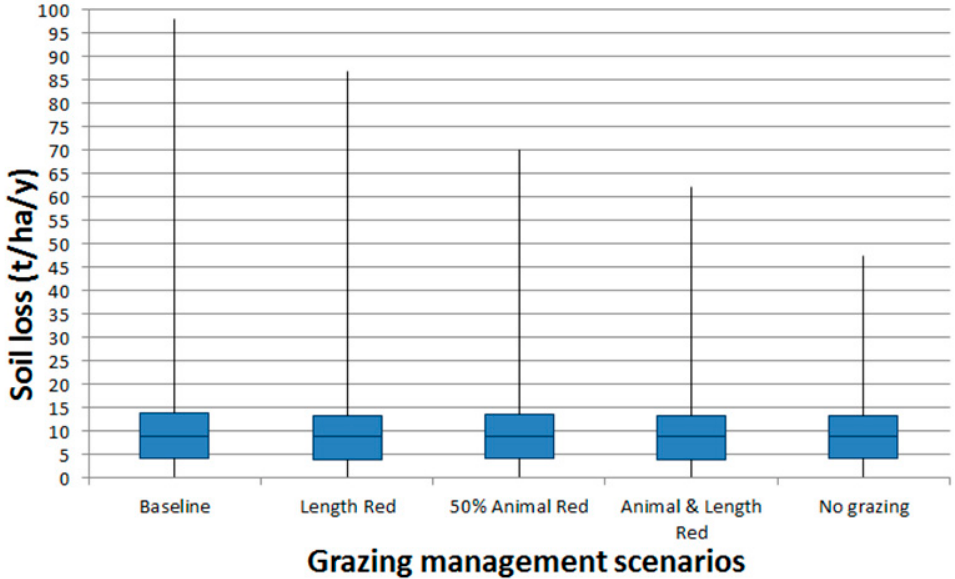
Figure 7. Box plots of mean annual (1986–2006) soil loss (t/ha) from Samothraki’s subbasins at the baseline scenario and four alternative grazing management scenarios. baseline scenario and four alternative grazing management